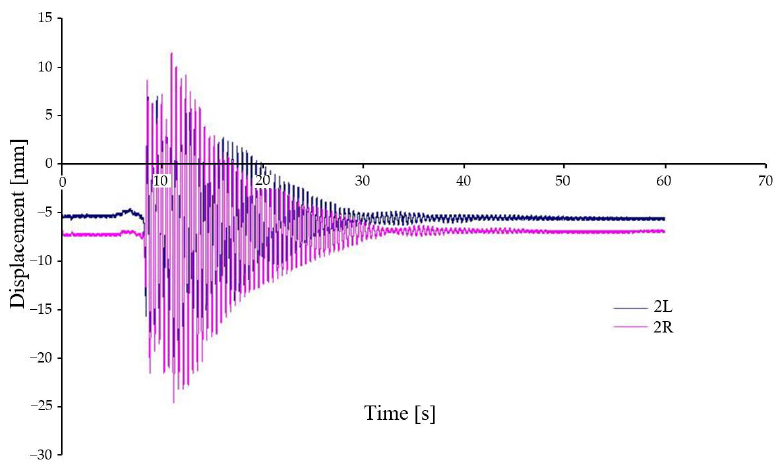
Figure 15. Relative displacement between car body and chassis frame—variant D-I.